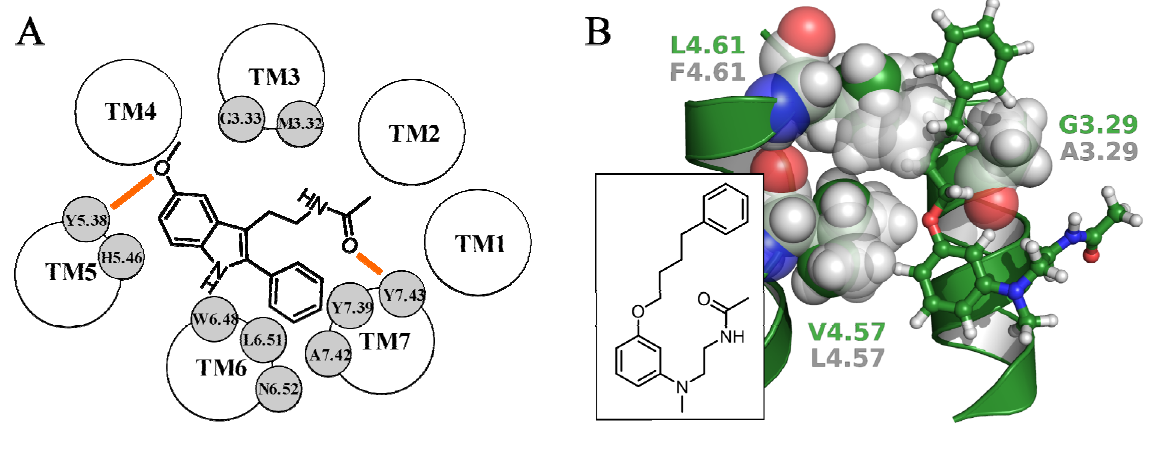
Figure 6. ( A ) Representation of the binding scheme of 2-phenylmelatonin within the MT 1 binding site proposed by Rivara et al. Hydrogen bond interactions are depicted with orange lines; ( B ) The MT -selective phenylbutyloxy derivative (ball-and-sticks representation, 1 with green carbons) docked within the MT receptor model. Residues 3.29, 4.57 and 4.61 1 ) and transparent light gray (MT ) spheres. The structure of are represented as green (MT 1 2 the phenylbutyloxy derivative is reported in the